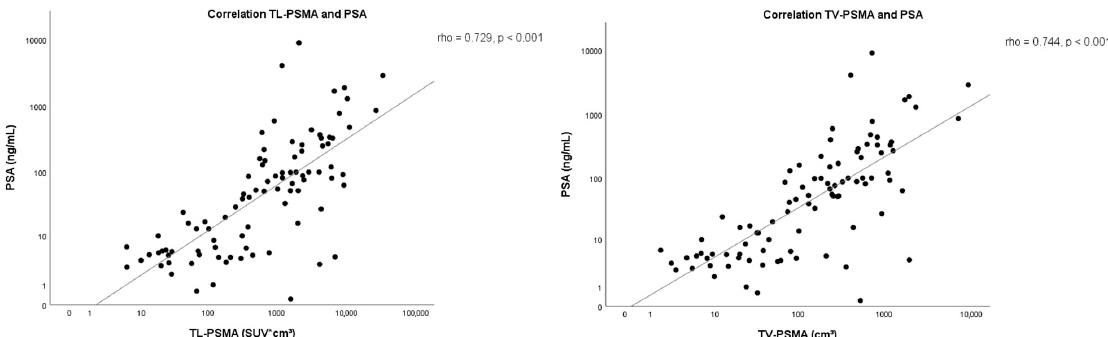
Figure 4. Correlation between the PSA value and the fractional total lesion [68Ga]Ga-PSMA-11 uptake volume (TL-PSMA) and PSA and the PSMA-derived total tumor volume (TV-PSMA) in men with metastatic prostate cancer.